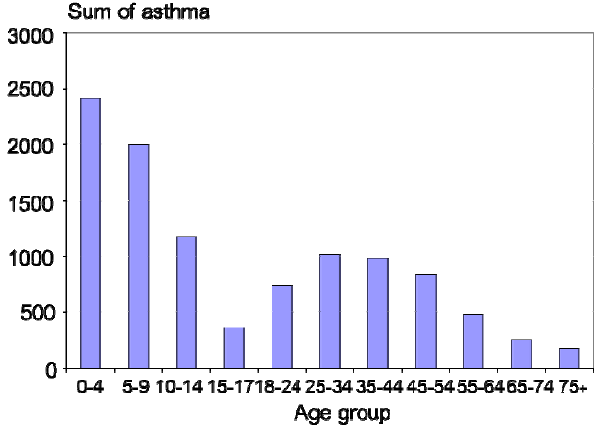
Fig. 6. Asthma incidences by age within five miles of PM 10 monitoring sites.